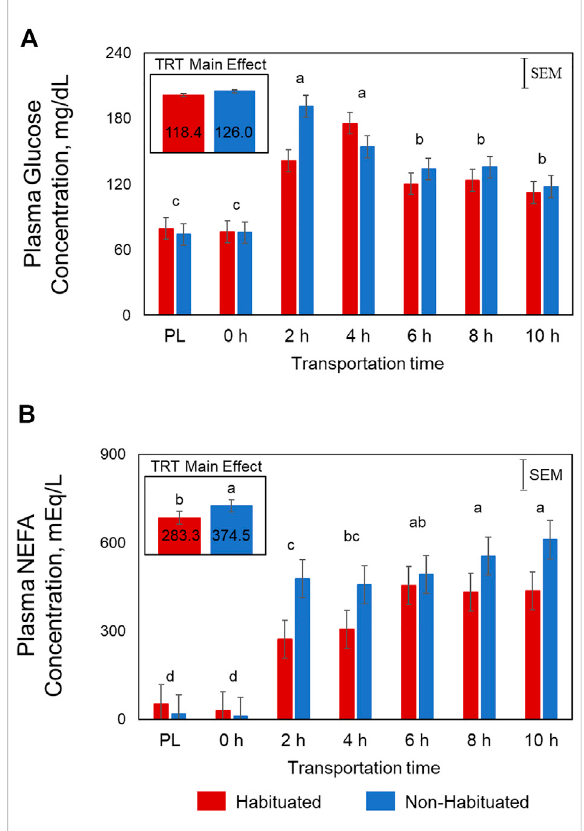
FIGURE 1 Effects of habituation treatment (TRT) and transportation time (Time; PL = Preload) on plasma (A) glucose (TRT, p = 0.14; Time, p < 0.01; TRT × Time, p < 0.05) and (B) non-esteri fi ed fatty acid (NEFA; TRT, p < 0.05; Time, p < 0.05) concentrations in